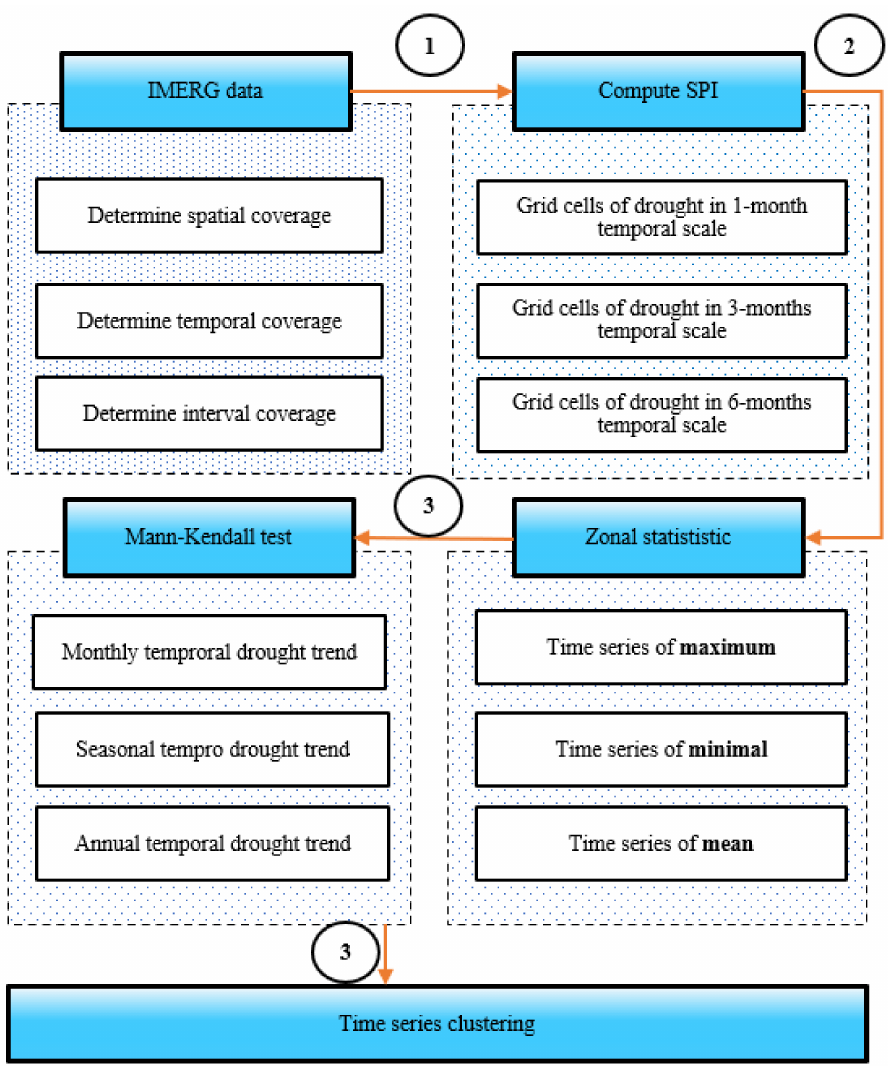
Figure 1. Methodology framework with the three main